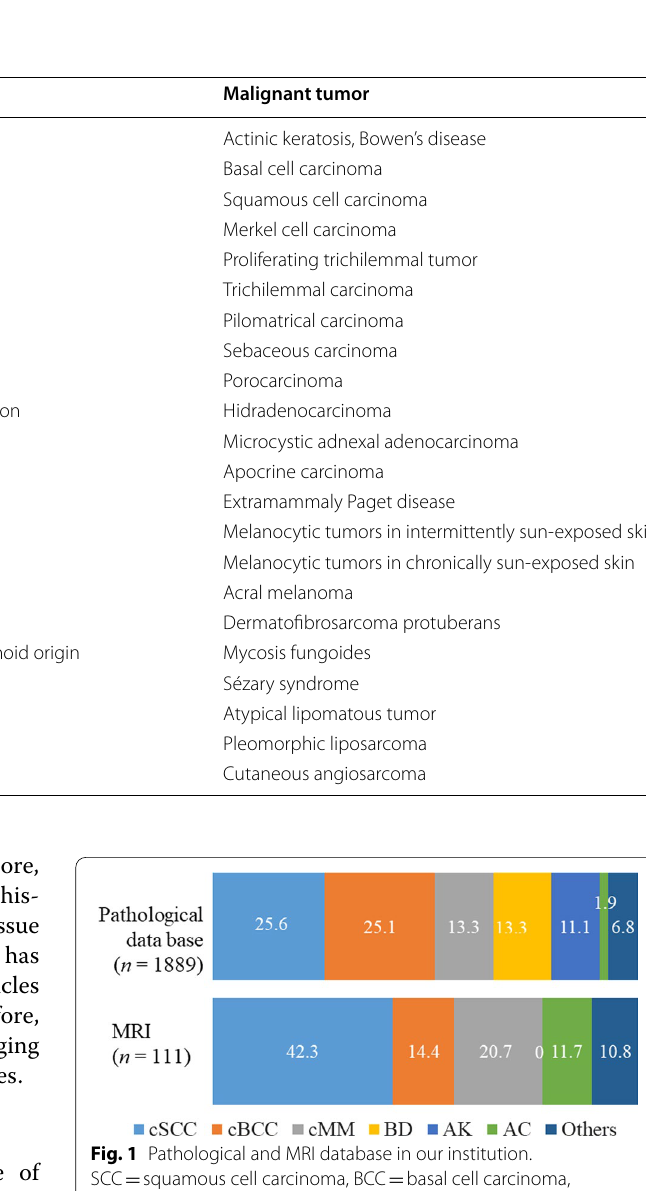
basal cell carcinoma, = Bowen’s disease, AK =